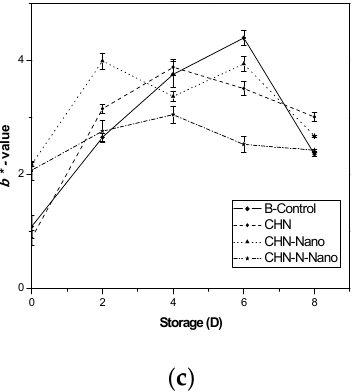
Figure 4. Effects of coating treatments on color index L * ( a ), a * ( b ) and b * ( c ).